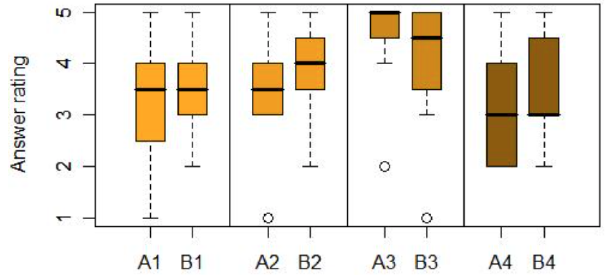
Figure 16. Distribution of answers to Questionnaire